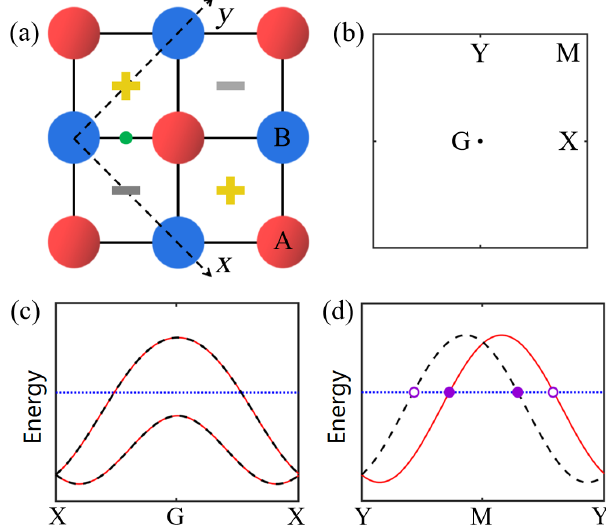
FIG. 1. (a) shows the monolayer case for the lattice structure respecting the space group P 4 =nmm . The translational symmetry from sublattice A to B is broken by an intrinsic effective electric field normal to the xy plane allowed by the symmetry [71 – 73], with (cid:2) labeling the direction. The green point represents the inversion center. Throughout the paper, the [10] ([01]) direction is along the x ( y ) axis. (b) shows the corresponding first Brillouin zone, with G , X , M , and Y the (0,0), ð π ; 0 Þ , ð π ; π Þ , and ð 0 ; π Þ ; k points, respectively. Notice that ð k in the Brillouin zone are x y Þ defined according to ð x; y Þ in (a), and the lines Σ ( M - Y - M ) and Y Σ 0 g . For ( X - G - X ) are invariant under the mirror symmetry f M G y j a system respecting the space group P 4 =nmm , its energy bands along Σ and Σ can be sketched in (c) and (d), respectively, with G Y 0 g invariant the red lines representing the bands in the f M y j i and the black dashed lines the subspace with eigenvalue m y ¼ þ − i . In the s -wave state, bands in the subspace with m y ¼ according to the criterion in Eq. (8), whatever the pairing order Δ is like on Σ , it does not contribute to topological super- G conductivity, while the sign-changed pairing on Σ illustrated in Y (d) (open purple circles and closed purple dots represent opposite signs of Δ on the Fermi points) leads to second-order topological 0 g . The superconductivity protected by the mirror symmetry f M y j blue dotted lines in (c) and (d) label the Fermi